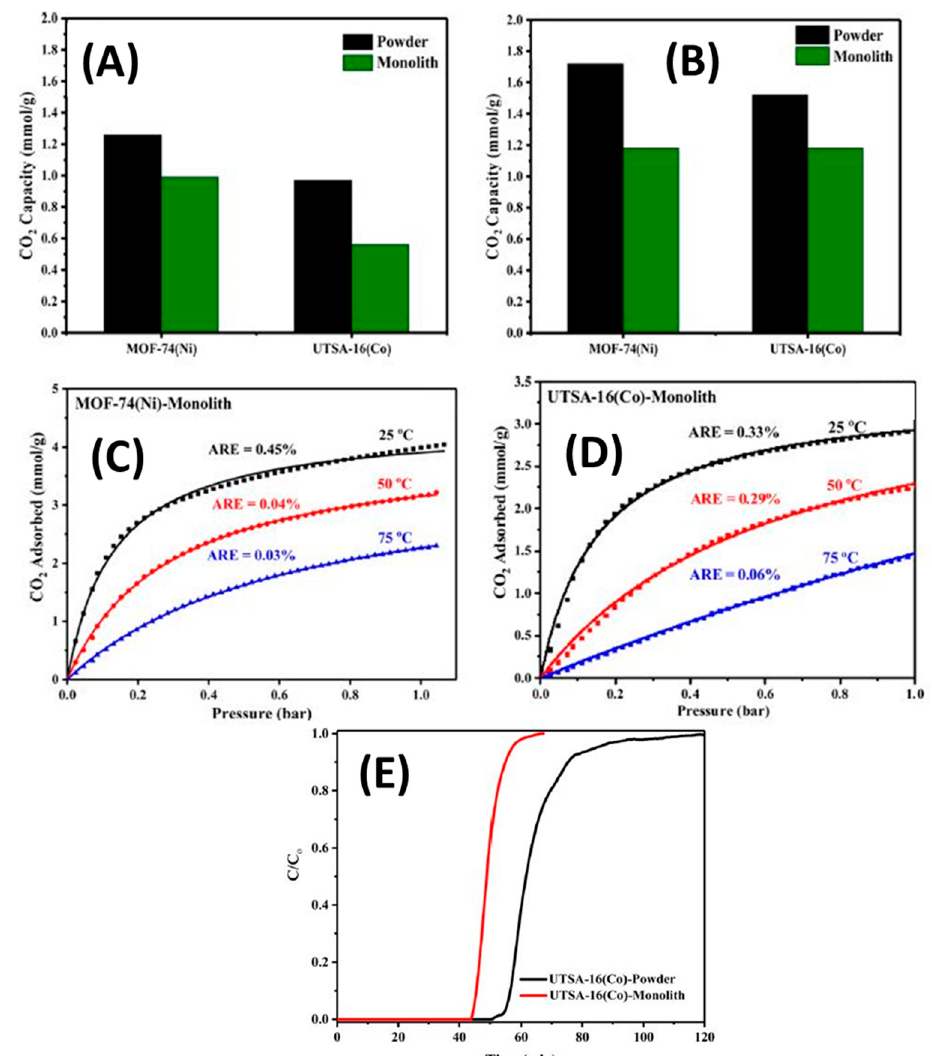
Figure 17. ( A , B ) CO 2 capacities of 3D-printed MOF monoliths and corresponding powders under (A) 3000 and (B) 5000 ppm CO 2 /N 2 at 25 °C and 1 bar [62]. ( C , D ) CO 2 adsorption isotherms of 3D-printed (C) MOF-74(Ni) and (D) UTSA-16(Co) monoliths at 25, 50, and 75 °C. Symbols show the experimental data, and solid lines represent the fitted isotherms with the average relative error (ARE). ( E ) Breakthrough profiles of the 3D-printed UTSA-16(Co) monolith and its corresponding powder using 5000 ppm CO 2 /N 2 at 25 °C. Reproduced with permission from [62]. Copyright American Chemical Society, 2017.